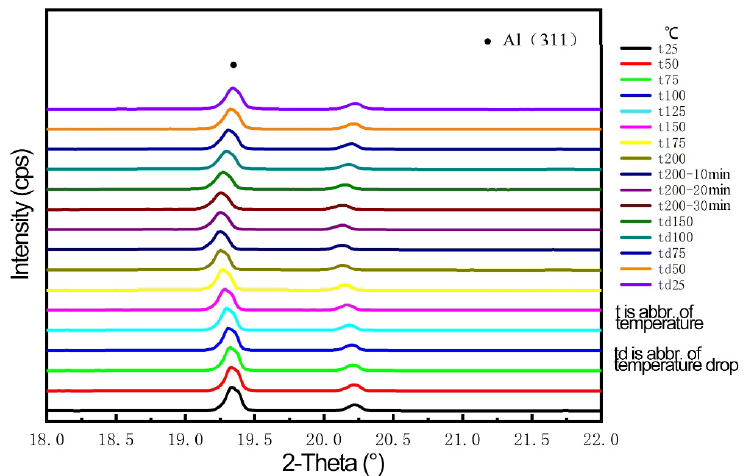
Figure 6. Variation of diffraction angle during different temperatures.